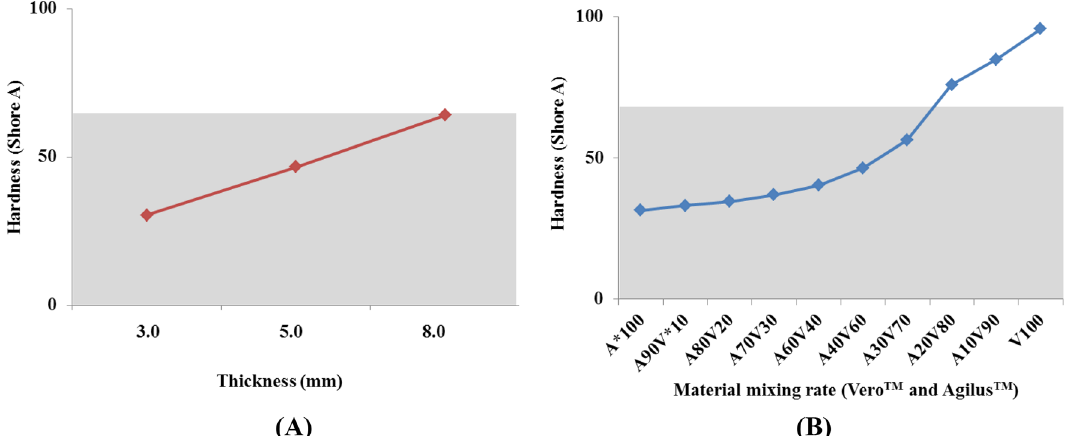
Figure 4. Comparison of mechanical properties of 3D printing materials. The gray zone in both graphs is human skin to shore A hardness (mean) ranging from 0 to 65. ( A ) Hardness with different thickness values of FDM printing materials. ( B ) Hardness according to the mixing ratio of two PolyJet materials. (A*: Agilus, V*: